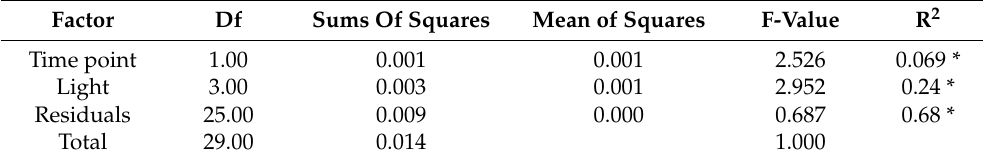
Table 4. Effects of light and time on the metabolites in Planktothricoides sp. (SR001)—PerMANOVA.